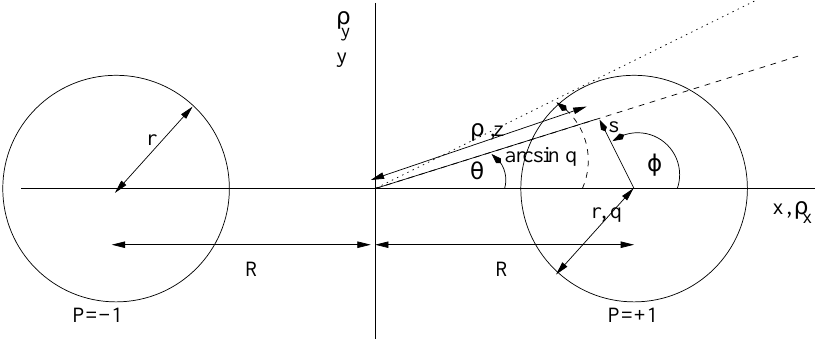
Fig. 1. The two-dimensional area and the Cartesian and polar coordinates covered by the two circular sub-pupils. The center of symmetry and origin of the global circular coordinates is at x = y = 0. In the (cid:12)rst quadrant, the limit (cid:18) (cid:20) arcsin q of integration is given by the tangent of a radial vector on the pupil with index P = +1 along the dotted